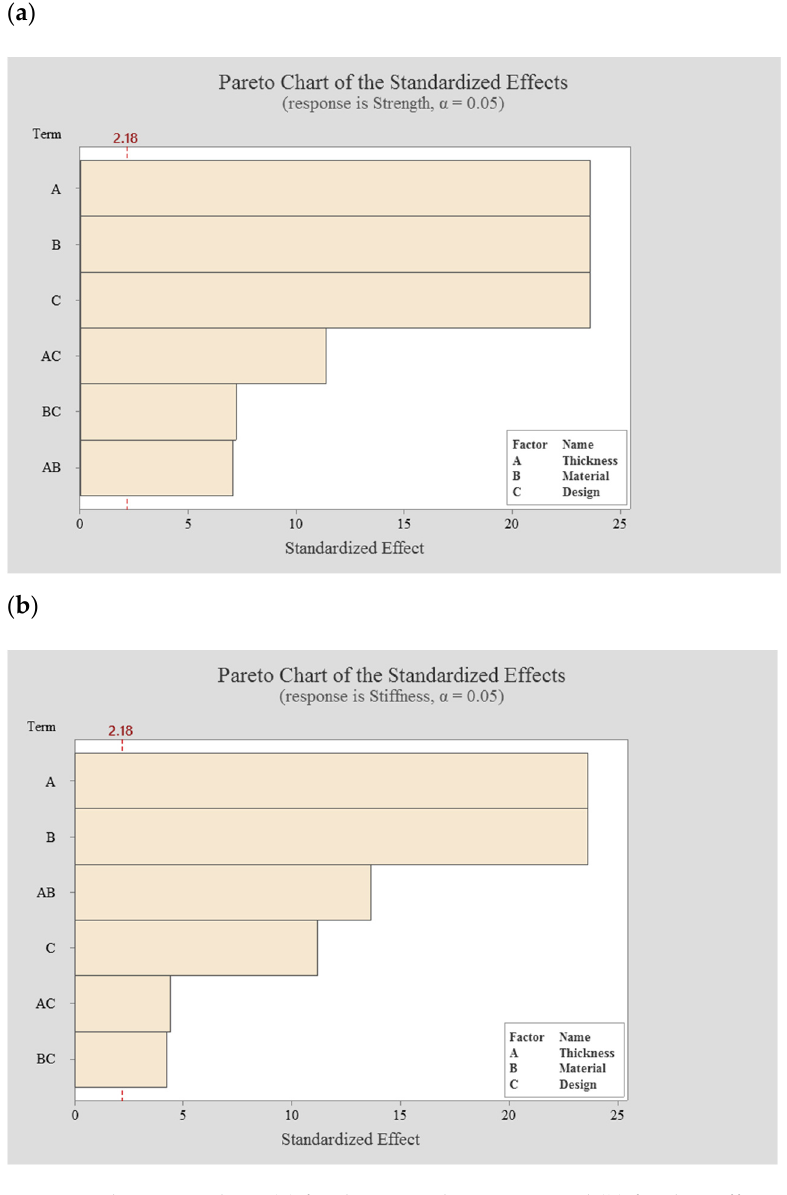
Figure 7. The Pareto chart; ( a ) for the strength response and ( b ) for the stiffness response.